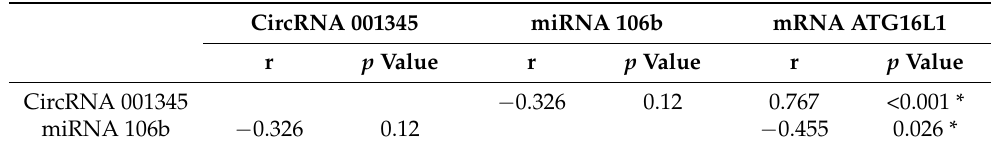
Table 3. Correlation between competing endogenous RNAs (CircRNA 001345, miRNA 106b, and mRNA ATG16L1).